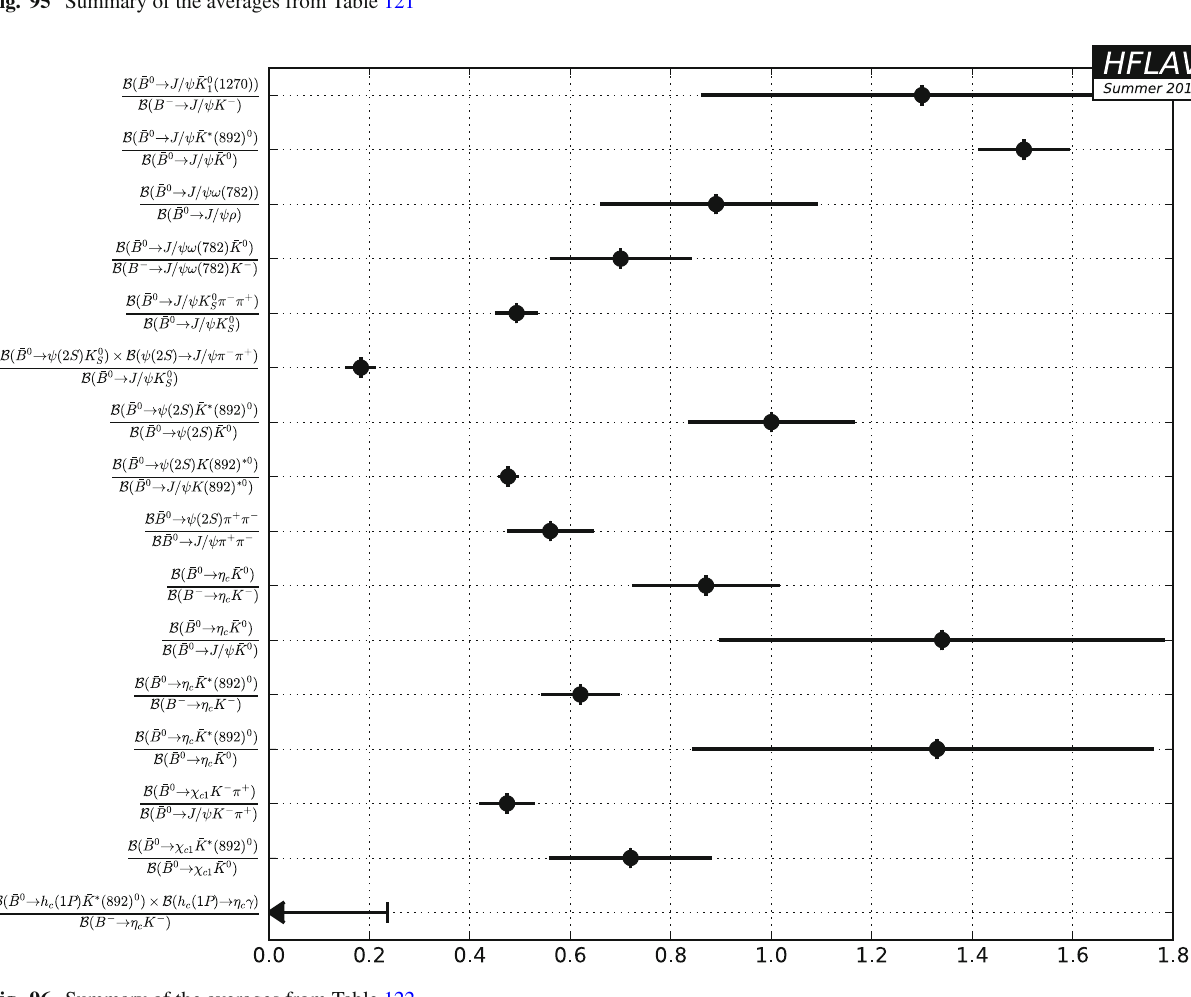
Fig. 96 Summary of the averages from Table